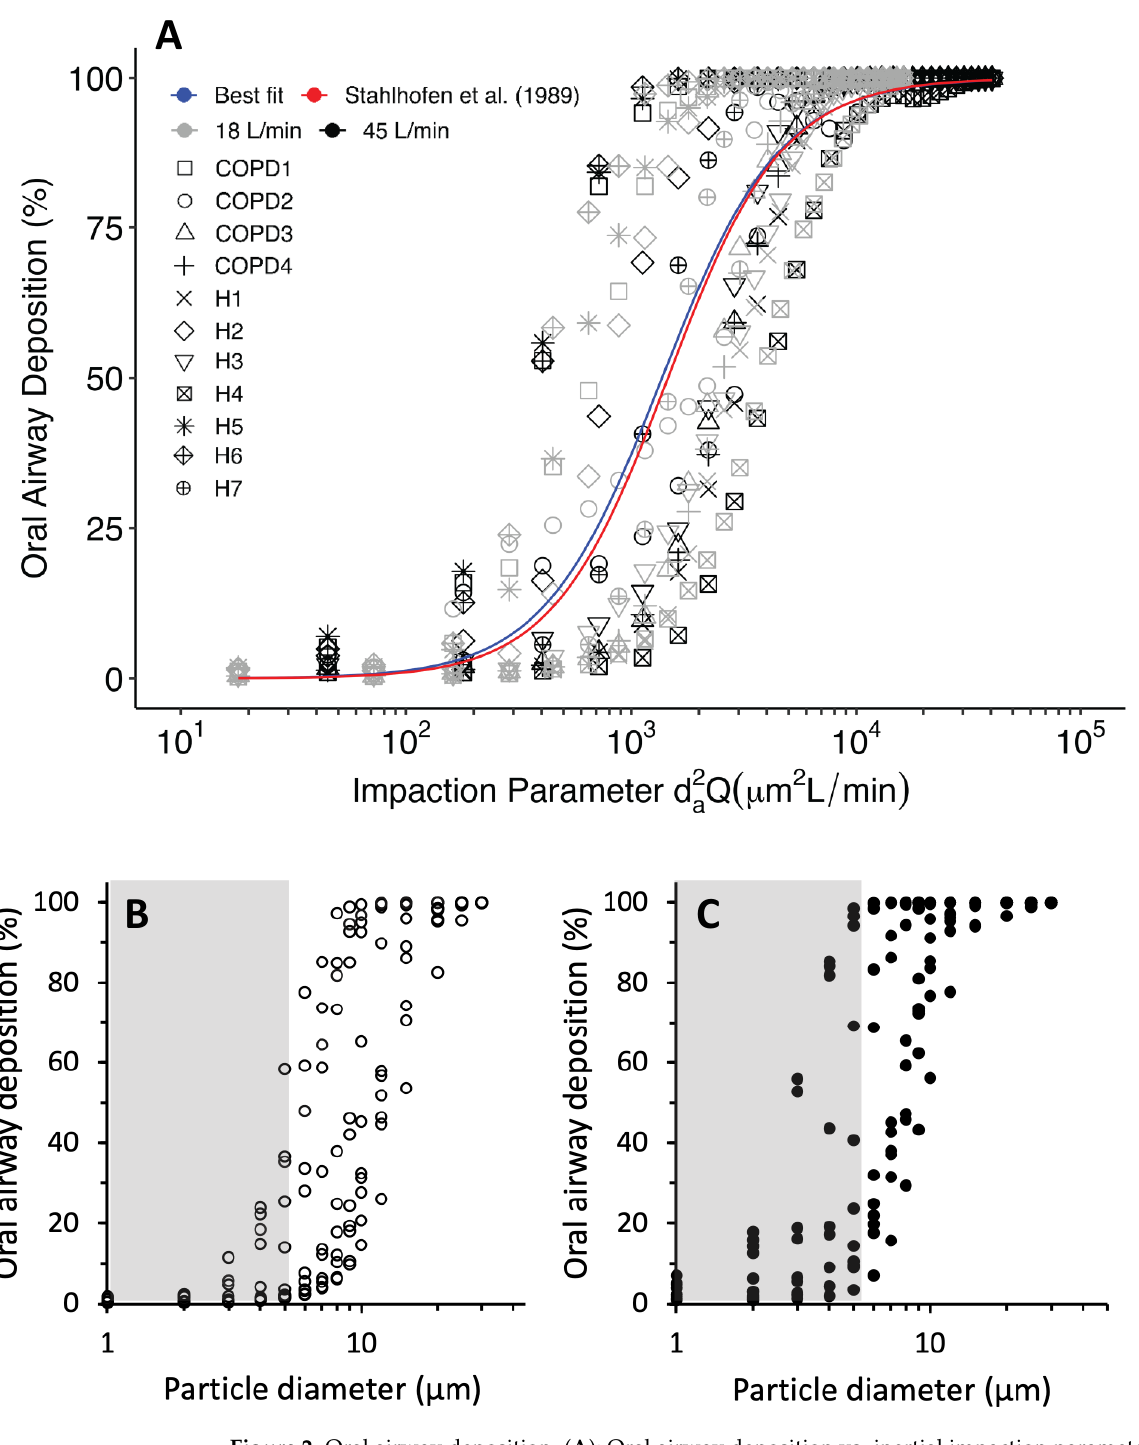
Figure 2. Oral airway deposition. ( A ): Oral airway deposition vs. inertial impaction parameter. Gray symbols and black symbols represent deposition fraction at inhalation flowrate 18 and 45 L/min, respectively. Empirical prediction is based on Stahlhofen equation (Equation (4)). ( B , C ): Deposition vs. particle diameter at an inhalation flow rate of 18 L/min (panel ( B )) and 45 L/min (panel ( C )). For particles >10 µ m in diameter, data are only shown for 12, 15, 20, 25 and 30 µ m. Gray area in each panel highlights the optimum aerodynamic particle size distribution (i.e., 1–5 µ m) for most pharmaceutical aerosols.